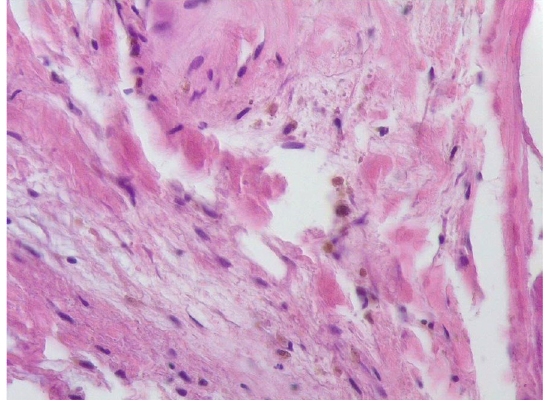
Fig. 2 Microscopic view of the pigmented valve with hematoxylin and eosin staining, detailed view of pigmented, brown-coloured macrophages